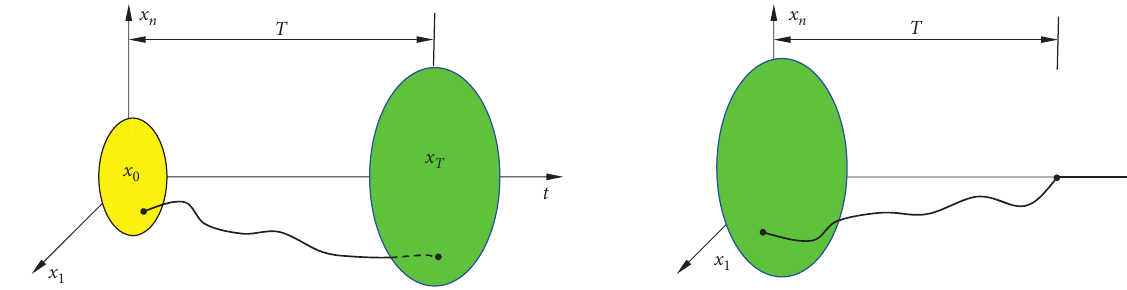
Figure 1: Schematic illustration of finite-time stability in a quantitative